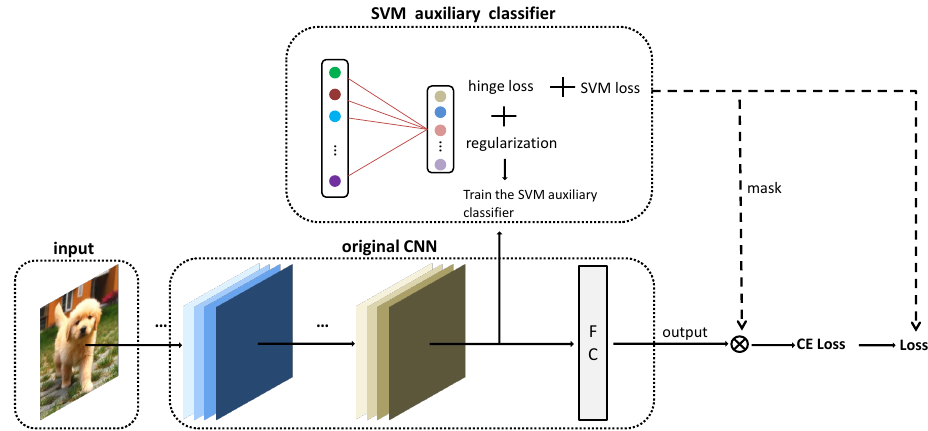
Figure 2. Framework of our proposed